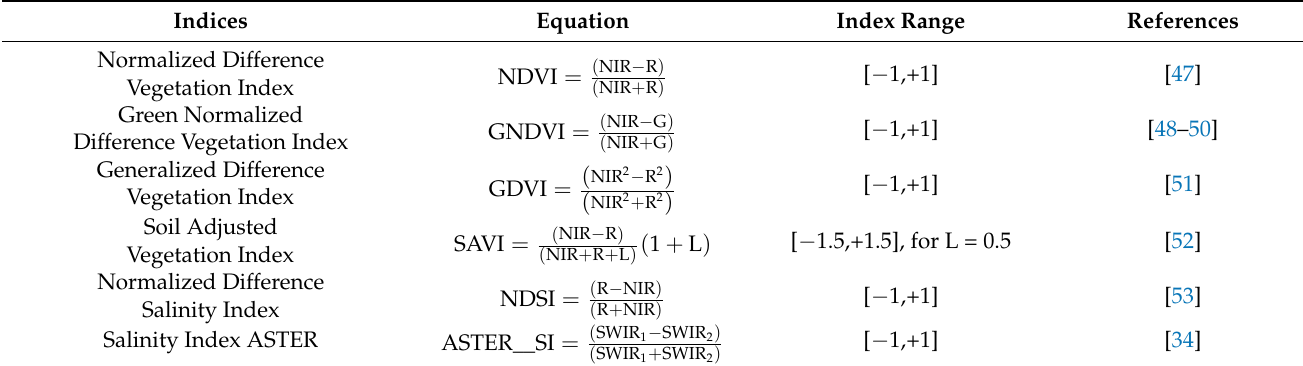
Table 3. Vegetation and salinity indices derived from Sentinel-2 satellite imagery. The R, G, NIR and SWIR bands are described in Table 2 and L is an empirical